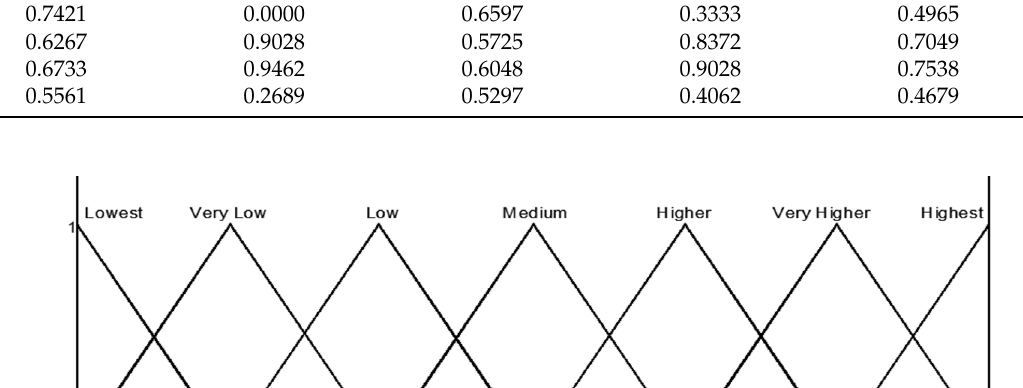
Figure 6. Membership functions of input .